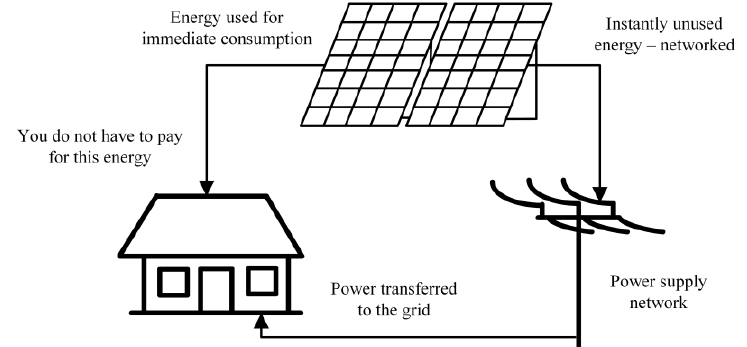
Fig. 3. Net settlement principle